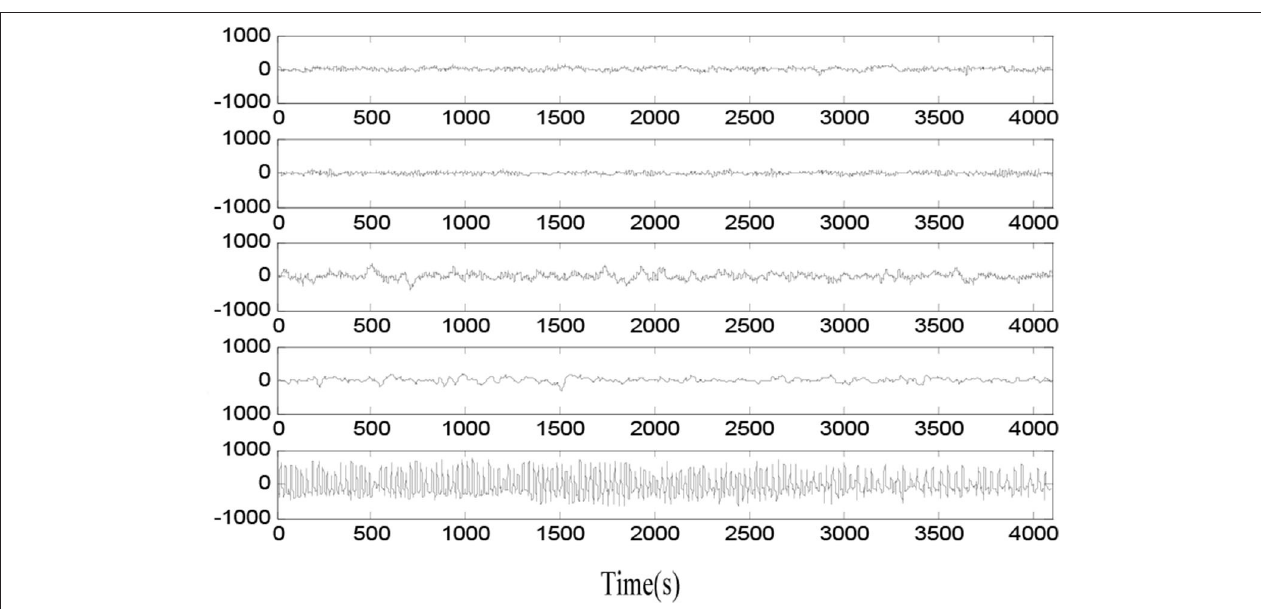
FIGURE 1 | Original epileptic EEG signals in five